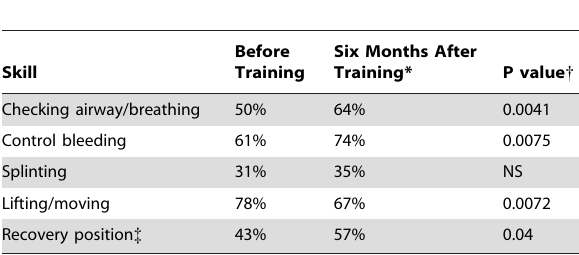
Table 1. Most commonly used skills and supplies from the first-aid course.